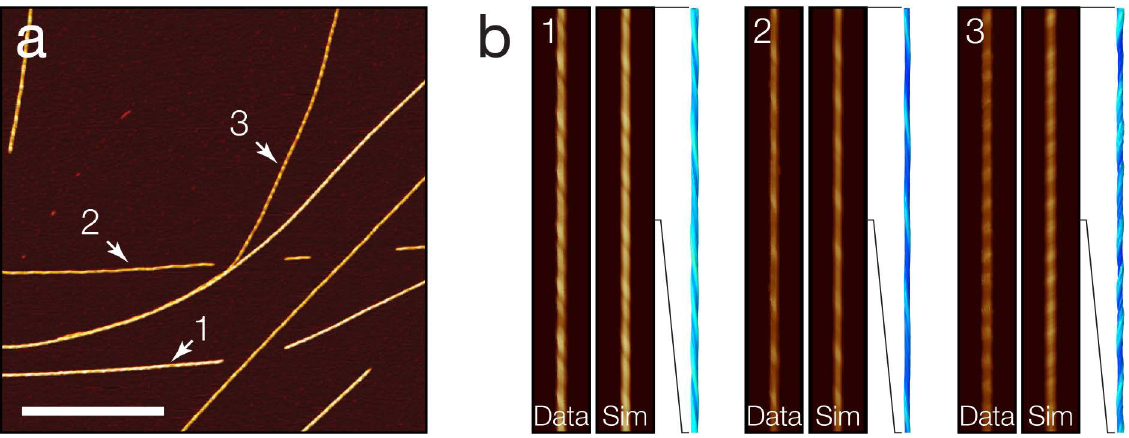
Figure 7: 3D surface envelope reconstruction of amyloid fibrils from AFM topography. (a) AFM topology image of amyloid fibrils assembled from short peptide with the sequence HYFNIF [17,24]. The scale bars represent 1 mm. (b) 3D surface envelope models for each fibril indicated in (a) are shown together with a comparison of the original straightened uncorrected fibril images and the simulated AFM images from the final 3D models. Segments of 500 nm are shown for each fibril model and 1 mm for the images for